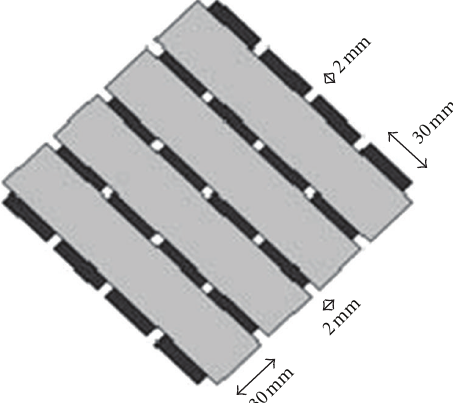
Figure 1: Representative volume used to fabricate the specimens.